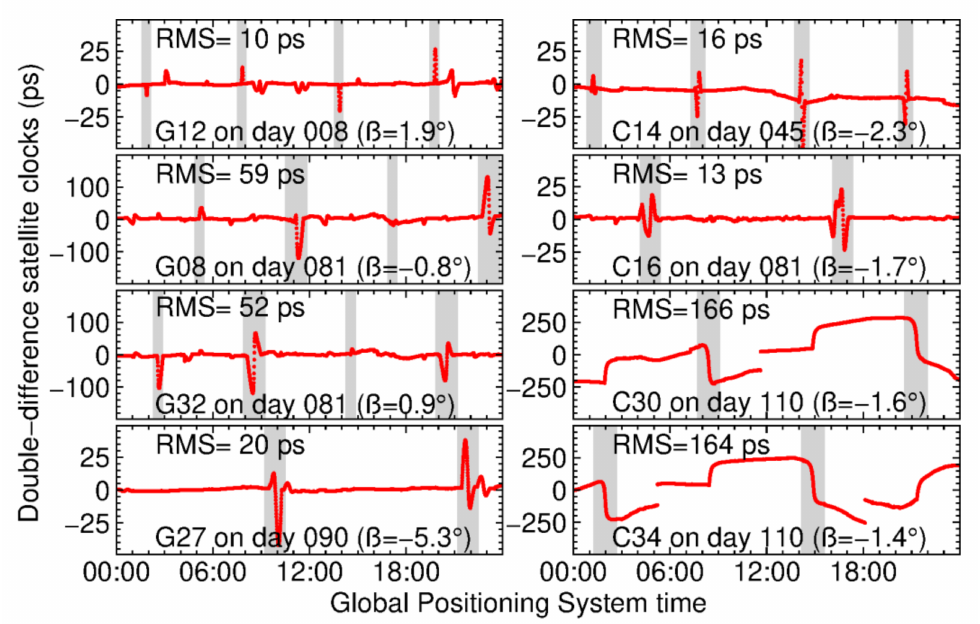
Figure 2. Time series of double-difference satellite clocks for satellites G08, G12, G27, G32, C14, C16, C30 and C34 in 2020. The reference satellites are G01 and C06 for GPS and BDS satellites, respectively. The red dots are the double-difference satellite clocks computed using the clocks based on nominal attitudes and attitude quaternions. The gray zones denote the eclipsing periods of corresponding satellites. The RMS error at the top part of a panel is for the eclipsing period. The average sun elevation angle for corresponding day is shown at the bottom part of a panel. Note that the different panels of the figure have different